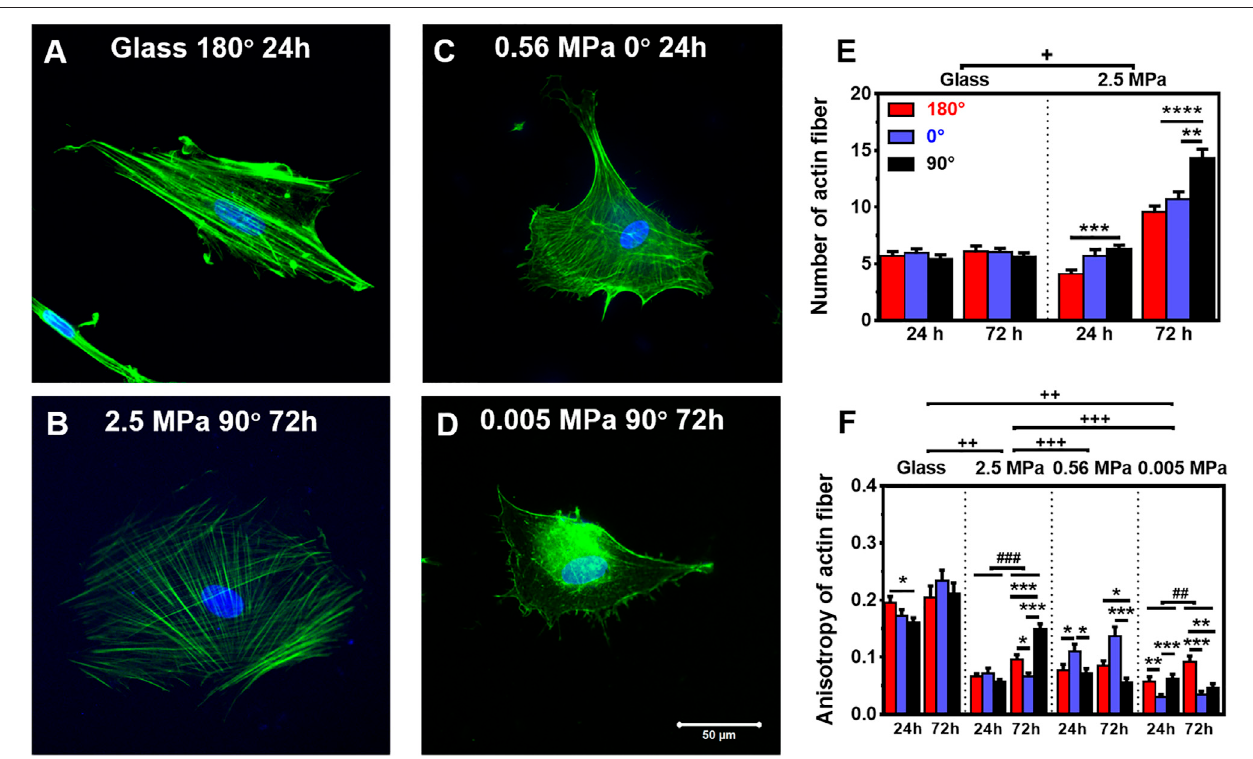
FIGURE 3 | Structure and number of actin stress fi bers. (A – D) Typical images of perinuclear actin fi bers onto glass (A) 180 ° , 24 h, 2.5 MPa, (B) 90 ° , 72 h, 0.56 MPa, (C) 0 ° , 24 h, or 0.005 MPa, (D) 90 ° , 72 h poly-dimethylsiloxane. Bar = 50 µm. (E,F) Number (E) and anisotropy (F) of stress fi bers onto the two types of substrates at 24 or 72 h. Here the number was de fi ned previously (Zhanget al., 2017), and the anisotropy term wasadopted from Boudaoud et al . (2014) (as referred in “ Materialsand Methods ” ).Datawerepresented asmean±SEfor~45cellsfrom threerepeatedexperiments inthree orientations.*,**,or ***, t -test, p < 0.05,0.01, or 0.001; ## or ### ,two-way ANOVAtest fordifferentgroupswithdifferenttime withcellorientation, p < 0.01or0.001; + , ++ ,or +++ ,three-wayANOVAtest fordifferences among stiffness, orientation, and duration, p < 0.05 0.01 or